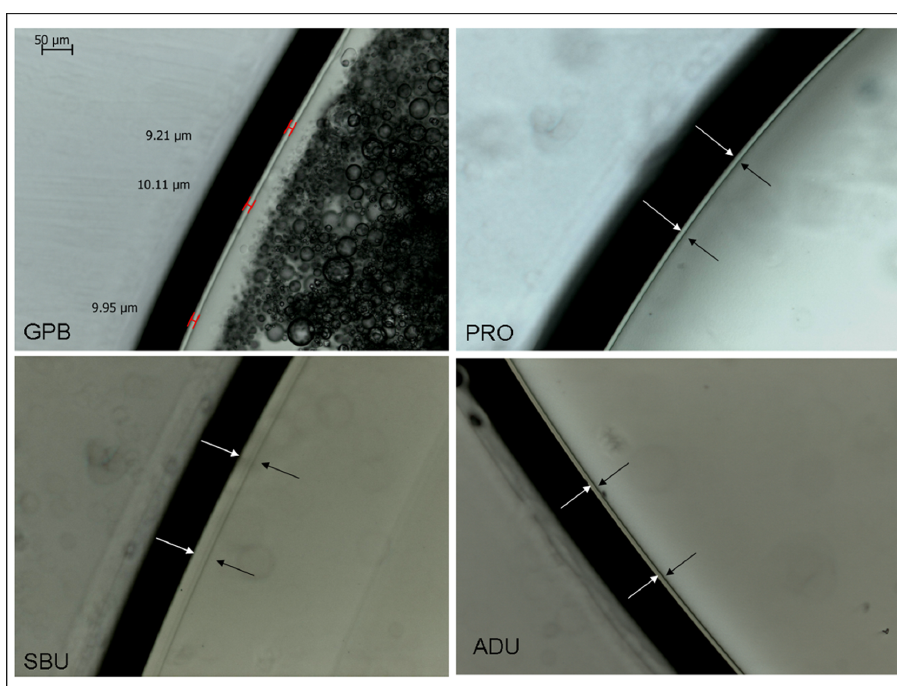
Figure 2. The extent of the O 2 -inhibition layer in representative universal adhesives. In G Premio Bond (GPB) image the measurement sites are marked. Arrows show the inhibited layer in Prelude One (PRO), Scotchbond Universal (SBU) and Adhese Universal (ADU). Note the pronounced phase separation in GPB (200× magnification, bar = 50 μ m).